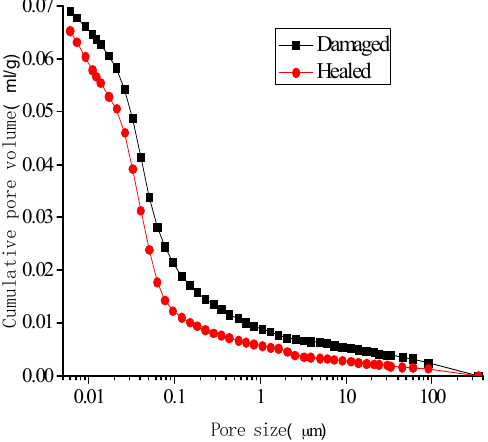
Figure 14. Cumulative-pore volume distribution for specimens without microcapsules.